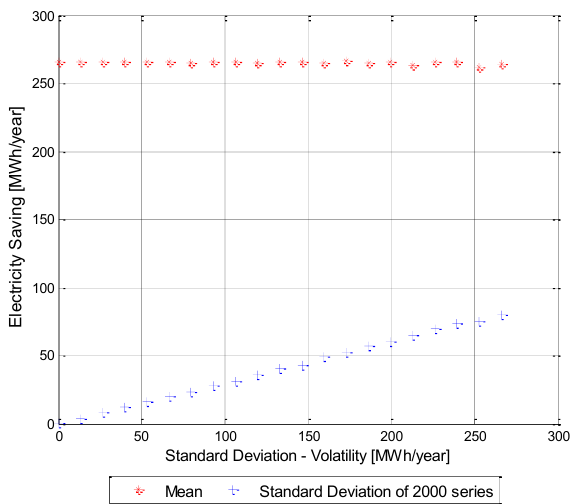
Fig. 7. Mean and standard deviation of electricity saving by variation of σ